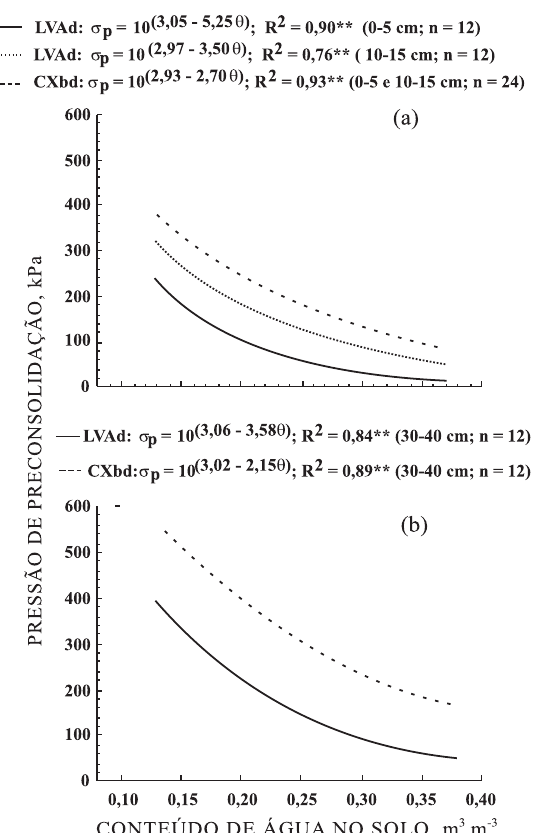
Figura 3. Modelos de capacidade de suporte de carga [variação de pressão de preconsolidação ( σσσσσ função do conteúdo de água no solo] do Latossolo Vermelho-Amarelo distrófico (LVAd) e do Cambissolo Háplico Tb distrófico (CXvbd), nas profundidades de 0 a 0,05, 0,1 a 0,15 e 0,3 a 0,4 m, no município de Goianésia,